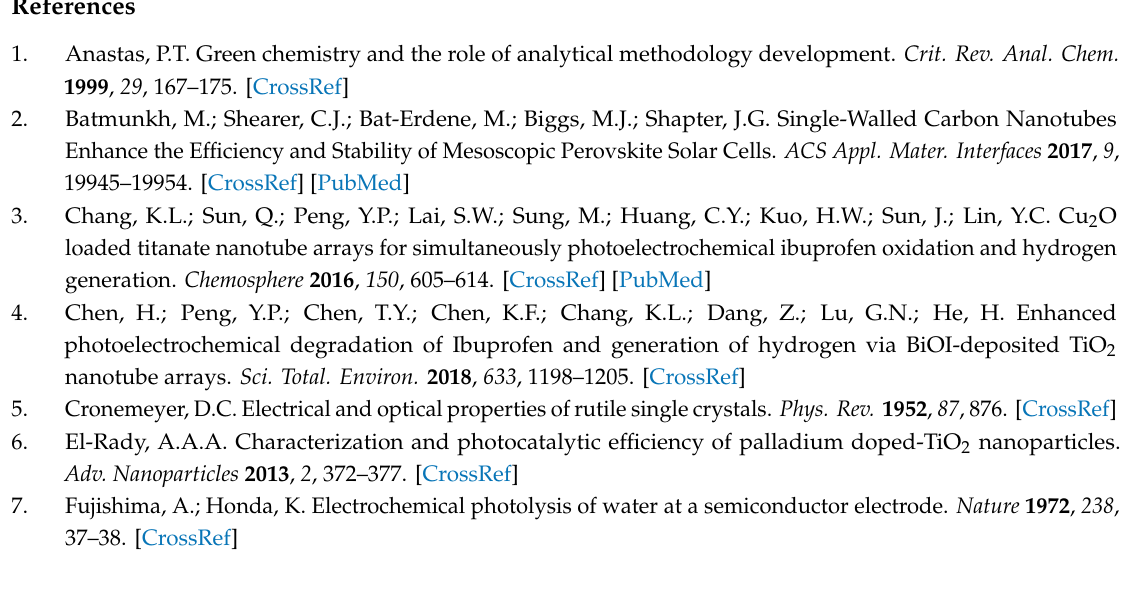
Figure S1: SEM mapping of Pd / TNAs-C; Table S1: EDS results of Pd /